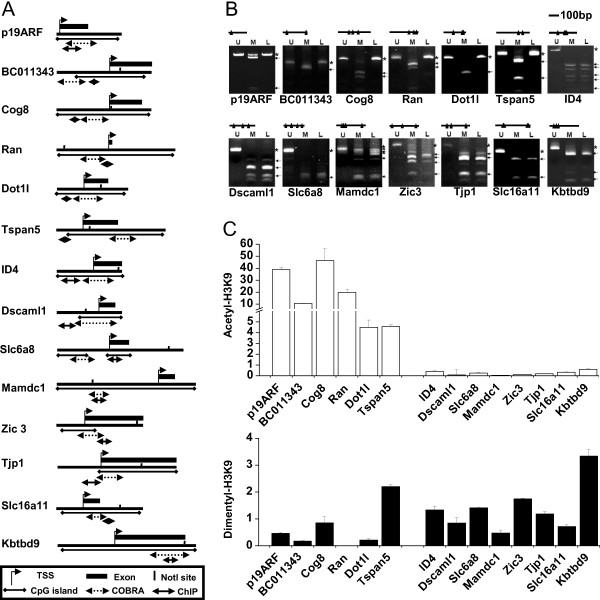
DNA methylation and histone modifications identified by COBRA and ChIP-PCR. A. The targets examined by COBRA and ChIP-PCR. NotI sites and regions for COBRA and ChIP-PCR are indicated. B. DNA methylation identified by COBRA. DNA from DBA2 mouse (U) and bisulfite treated DNA (M) were negative and positive controls, respectively. DNA from L1210 (L) was compared with controls. Arrows and stars indicate the methylated and unmethylated fragments, individually. C. Quantitative ChIP-PCR was conducted to examine the individual histone modifications of the same 12 selected genes including both methylated (right portion of graph) and unmethylated at CpG sites (left portion of graph). The histone modification level of each gene was compared with input genomic DNA from L1210 and indicated with bars: blank, acetyl-H3K9; black, dimethyl-H3K9. Each error bar represents the standard deviation calculated from triplicates.